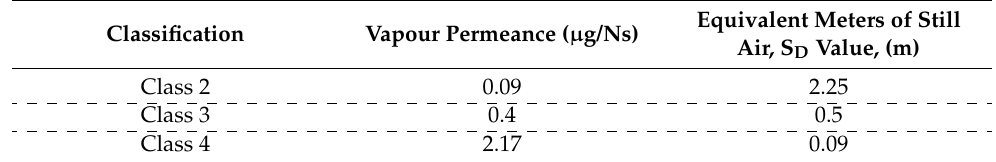
Figure 5. Wall assembly variations with external insulation ( a ), internal ( b ), and split ( c ). No WRB modelled (Case 1), WRB adhered to exterior of CLT panel (Case 2), and WRB installed to exterior of external insulation layer (Case 3). Table 3. Vapour control membrane classification as per Table 4 in AS 4200.1:2017, Pliable building membranes and underlays. S D values for the Class 3 and 4 membranes are in accordance with accordance with EN 1931 wet cup—23 ◦ C at 75% RH.